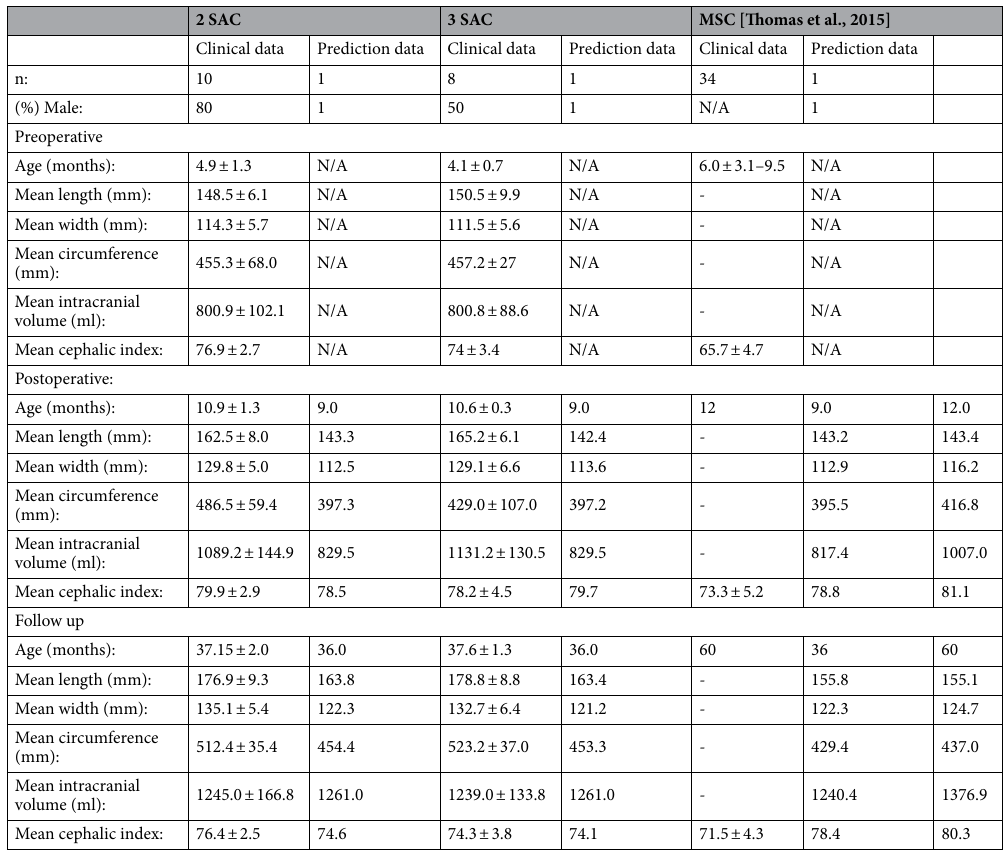
Table 1. Overview of predicted vs. in vivo measurements across all technique. Dashes indicate unavailable data. The pre-operative FE model used for this study was at the age of 4 months with skull length,